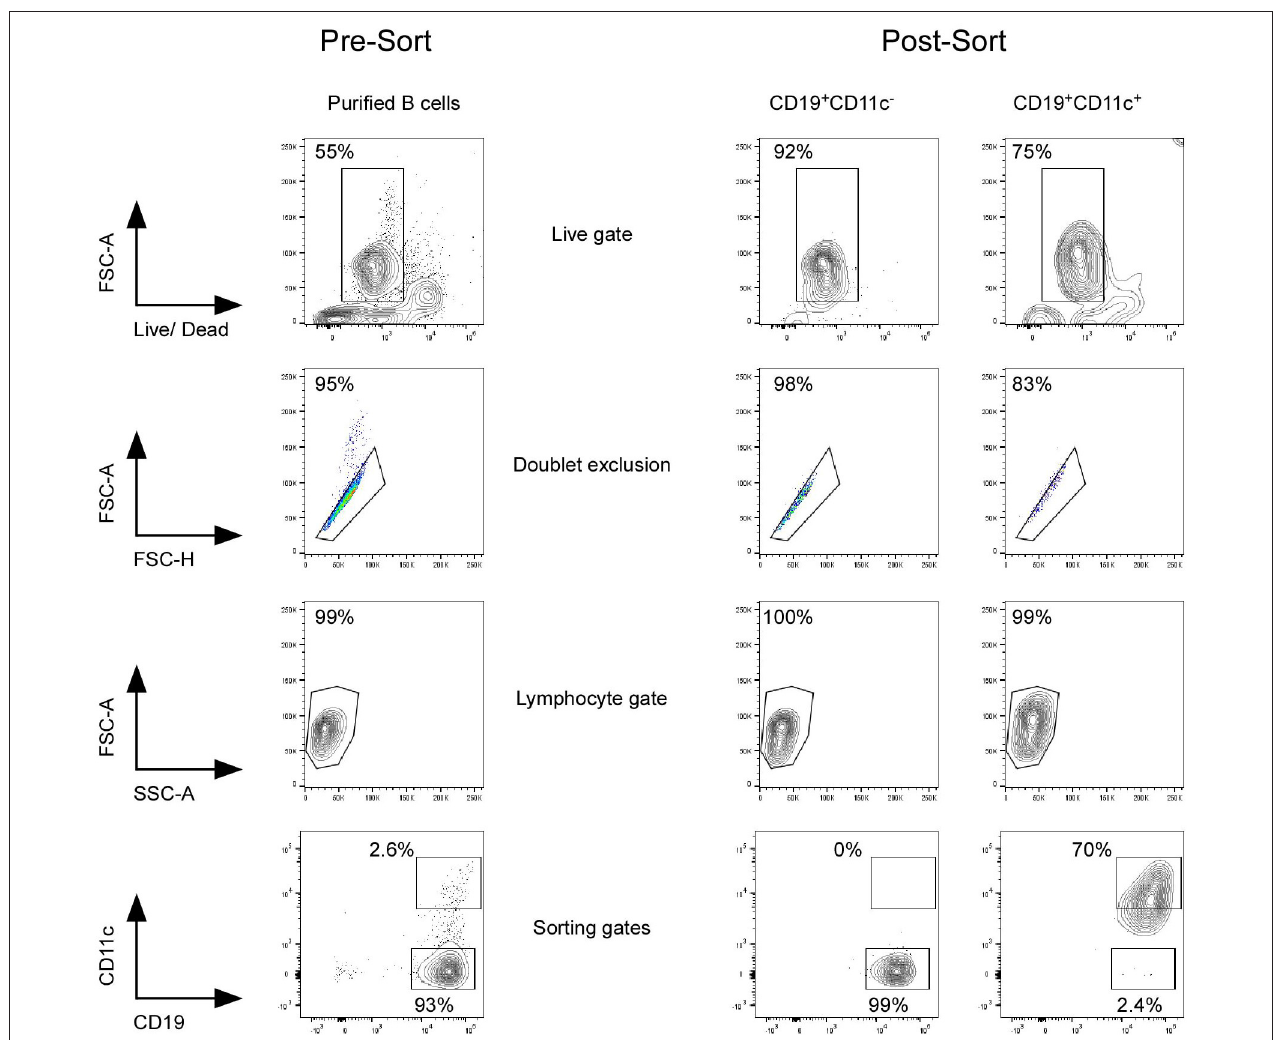
FIGURE 2 | Sorting strategy of CD11c + and CD11c − B cells. Purified B cells by negative selection using magnetic beads were stained with LIVE/DEAD Fixable Aqua Dead Cell Stain Kit, Fc Receptor Blocking Solution, and anti-CD19 and anti-CD11c antibodies. CD11c + , including CD11c hi and CD11c − CD19 + B cells, were sorted using FACSAria III. Purity of CD11c + and CD11c − B cells was checked after each sorting and was mean 95.3% ( ± 3.4%) and mean 99.3% ( ± 0.4%), respectively. Twenty-six different HD were sorted with age between 20 and 35 years